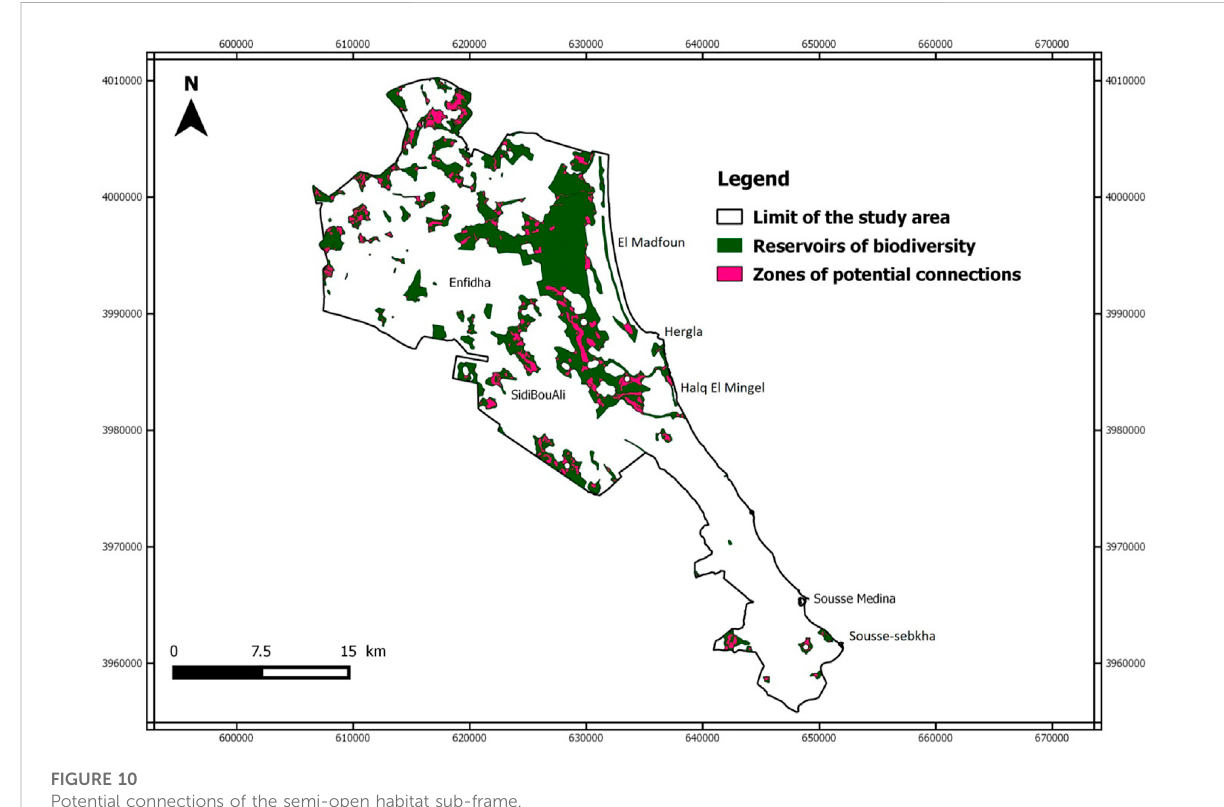
FIGURE 10 Potential connections of the semi-open habitat sub-frame.